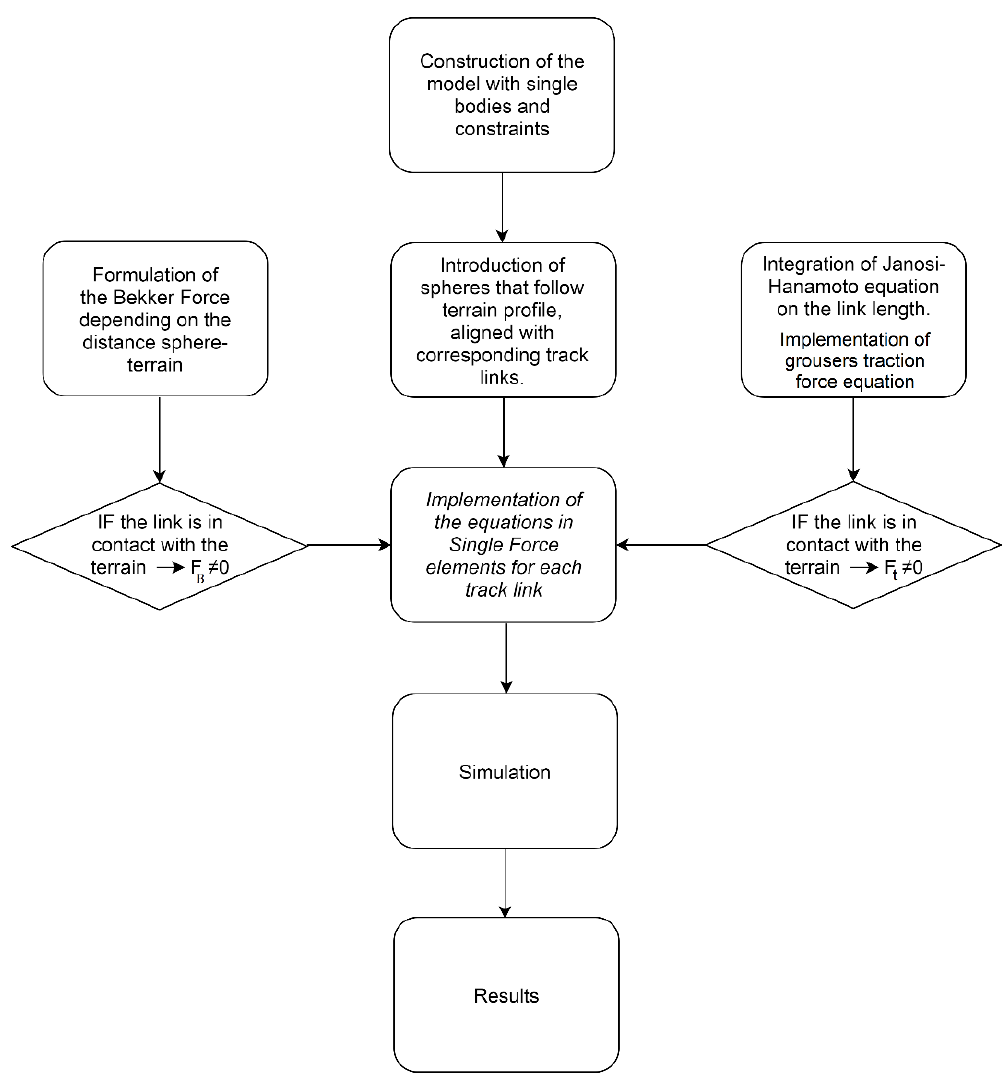
Figure 10. Complete multibody (MTB) code